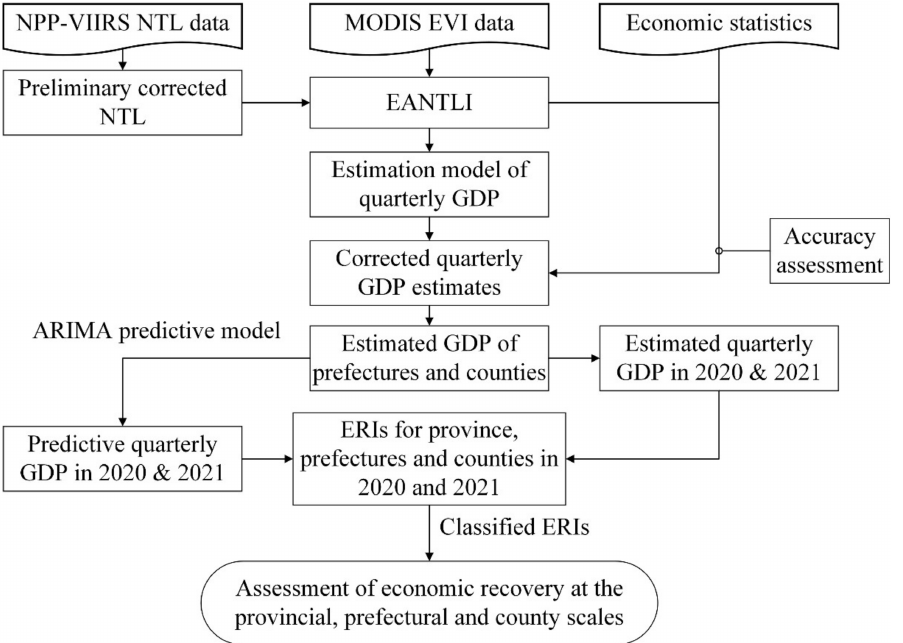
Figure 2. Schematic diagram for assessing the economic recovery of Hebei Province under the impact of the COVID-19